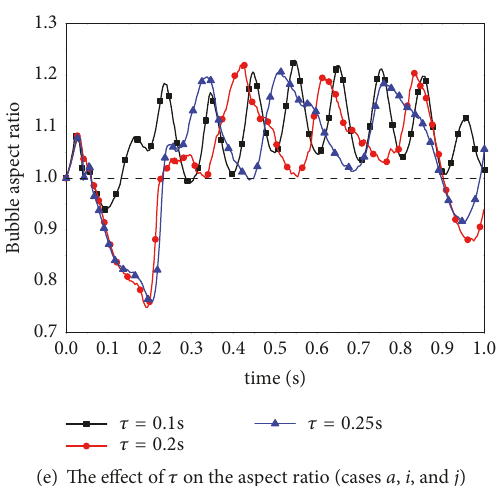
Figure 11: The change of bubble aspect ratio with time under the influence of each independent